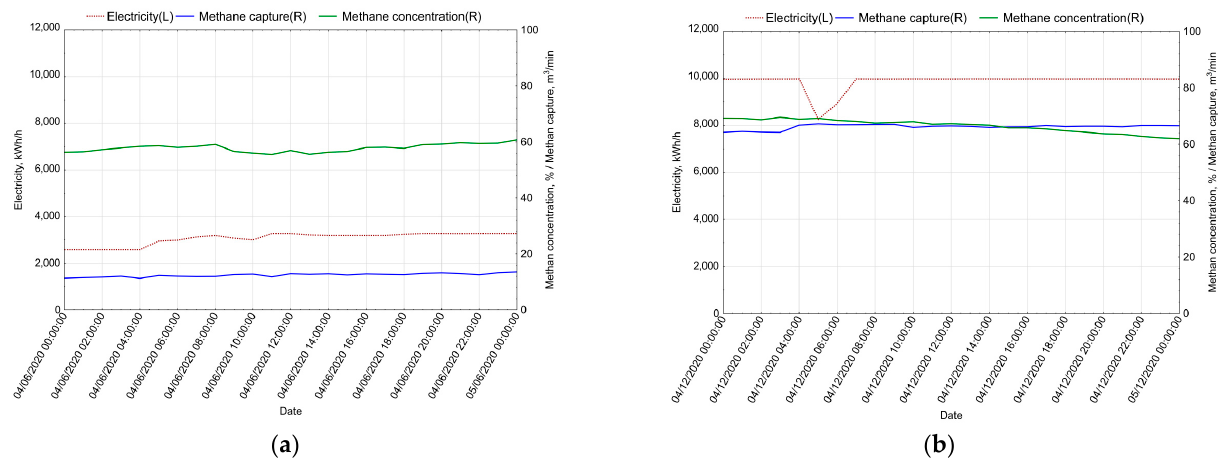
Figure 8. The daily course of variables in the analyzed period during the day by hour—An example of diagram ( a ) for summer period 04 June; ( b ) for winter period 04 December.